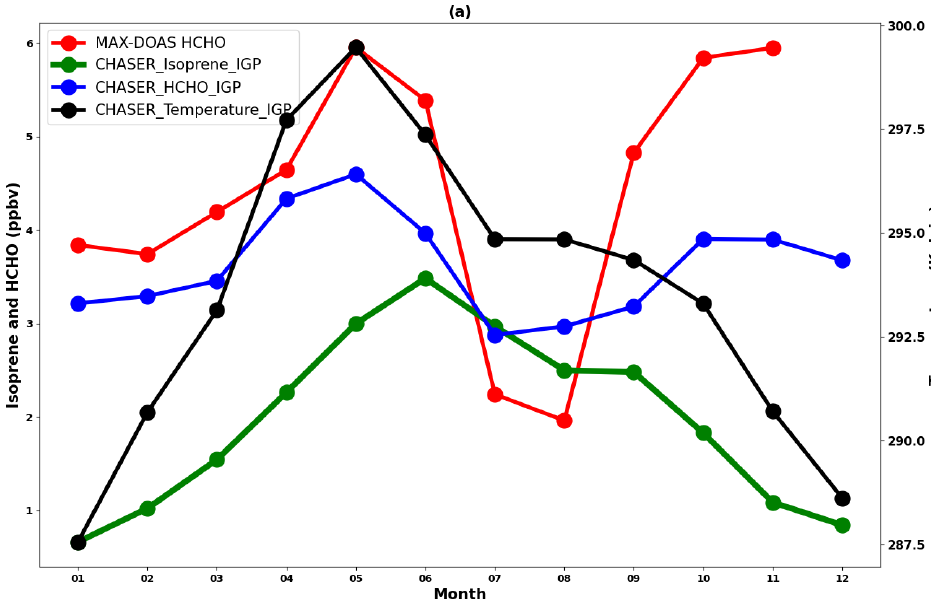
Figure 13. Seasonal variations in the MAX-DOAS (red) and CHASER (blue) HCHO concentrations at Pantnagar and the IGP region, respectively, in 2017. Only the coincident dates between the observations and model are plotted. The CHASER-simulated isoprene and temperature seasonality are shown in green and black colors, respectively. Only the daytime simulated values were considered for the plot.